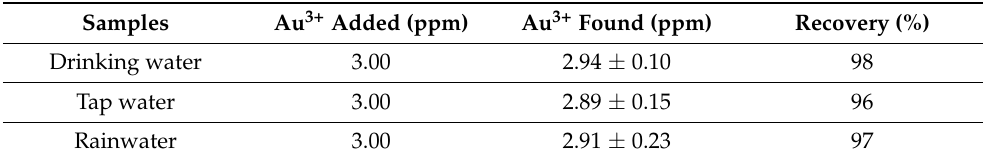
Table 1. Detection of Au 3+ in water samples using DHP-OH ( n =